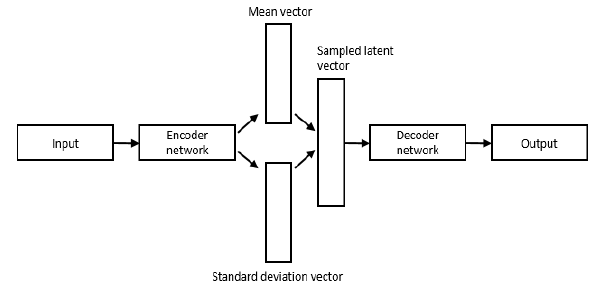
Figure 2. Variational autoencoder architecture